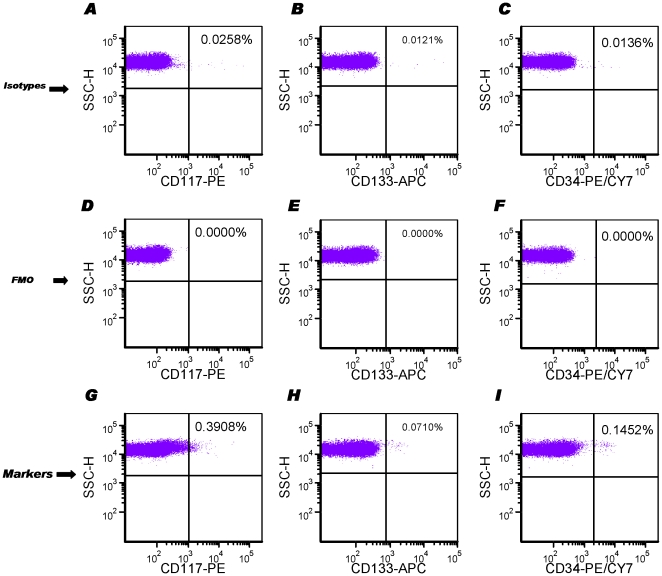
Fluorescence minus One (FMO) controls for the quantification of rare CPC events by FACS.Isotype controls were prepared by the combination of all the individual fluorophore-conjugated isotype control antibodies (A, B and C). FMO controls were prepared like isotype controls without adding a particular fluorophore-conjugated isotype control antibody, for instance fluorescence minus PE (D), fluorescence minus APC (E), fluorescence minus PE-Cy7 (F), respectively. The gating for each channel was defined to exclude nearly all background from the FMO controls on the 2D plots of FSC-H vs. individual fluorescence (e.g. PE, APC or PE-Cy7). Certain cell populations including CD117+ (G), CD133+ (H) and CD34+ (I) from a single sample were enumerated according to the gating strategy as above.